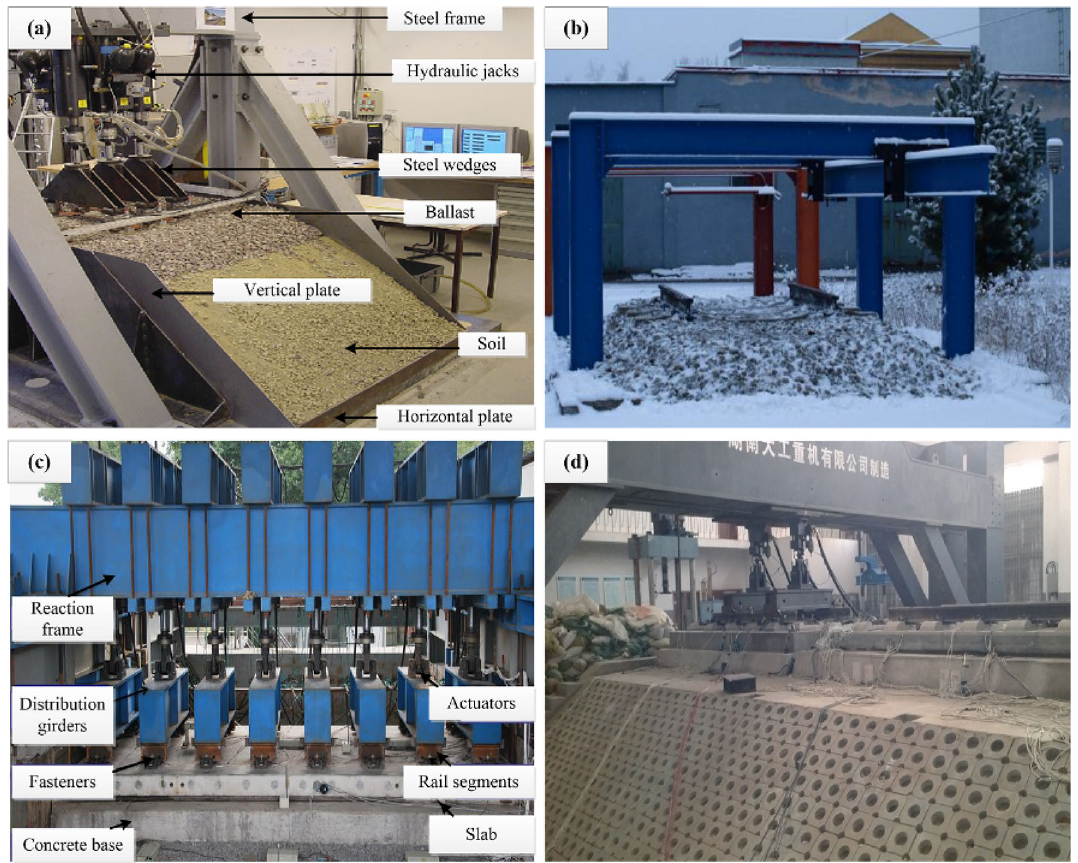
Fig. 1 Test platforms for track and subgrade structures in different research organizations: a University Paris-Est Marne-la-Valle´e; b University of Zˇilina; c Zhejiang University; d Central South